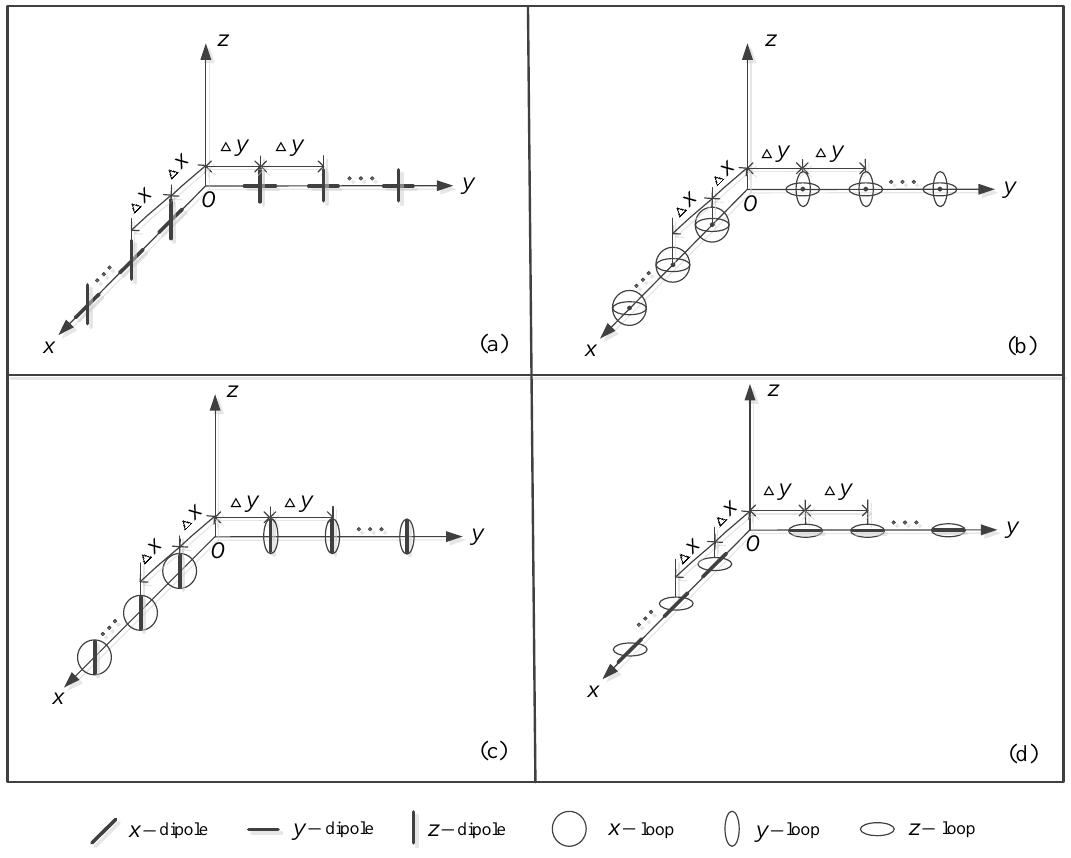
Figure 1. The four different antenna compositions of the L-shaped SD-VS array ( a ) dipole-dipole pairs; ( b ) loop-loop pairs; ( c ) dipole-loop pairs with z -dipoles; ( d ) loop-dipole pairs with z -loops.